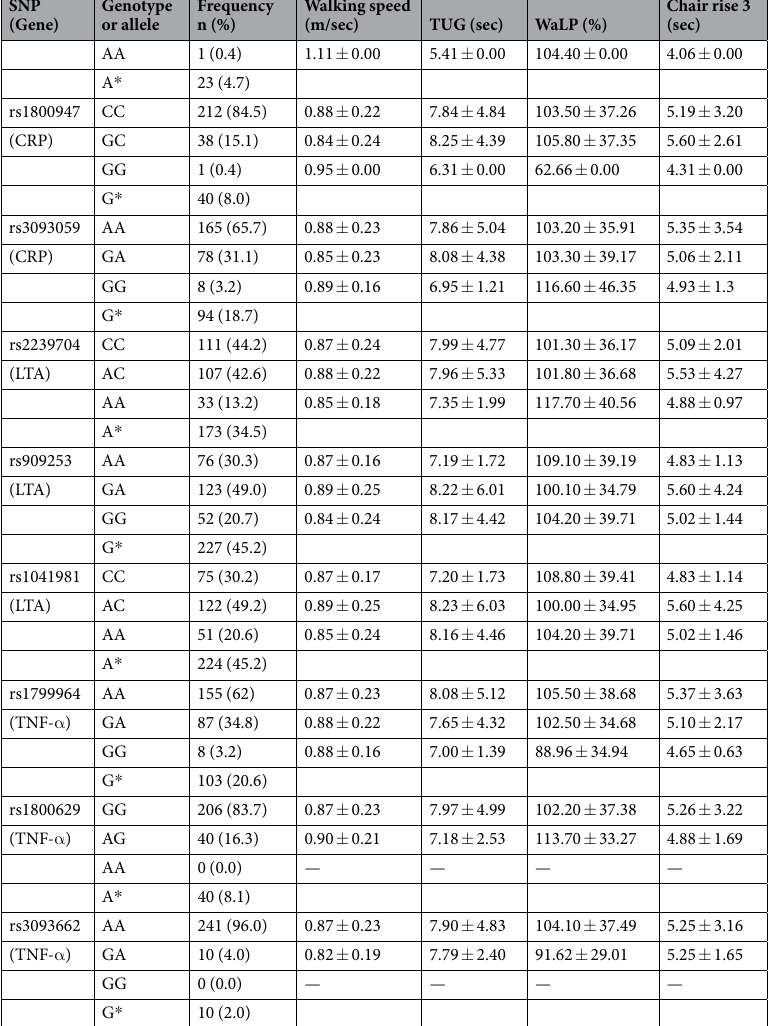
Table 2. Genotype and allele distributions of study subjects stratified by sex a . Data are presented as n (%) for genotypes and alleles. TUG: Timed up-and-go; WaLP: weight-adjusted leg press. * Minor allele. a: All P > 0.05 from Hardy-Weinberg Equilibrium